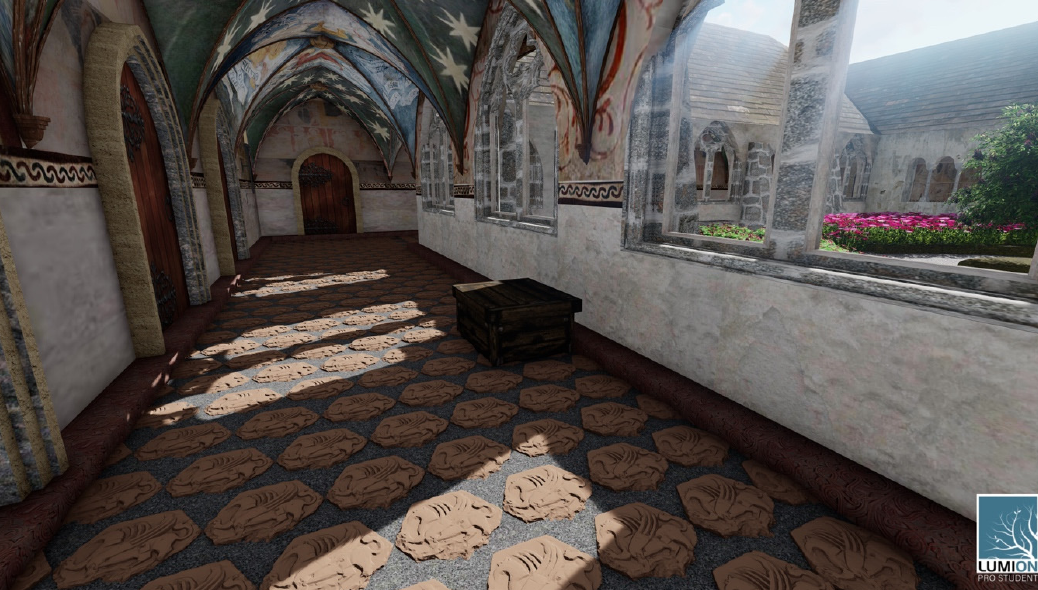
Figure 14. Interiors of the Gothic quadrature nearby the cloister including paintings of the era and the floor formed from tiles. Own work (2020).